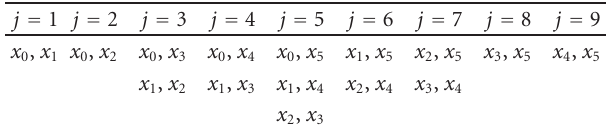
Algorithm 3: Model of the linear systolic array computation. Table 3: Illustration of index generation by Algorithm 4 for the example shown in Figure